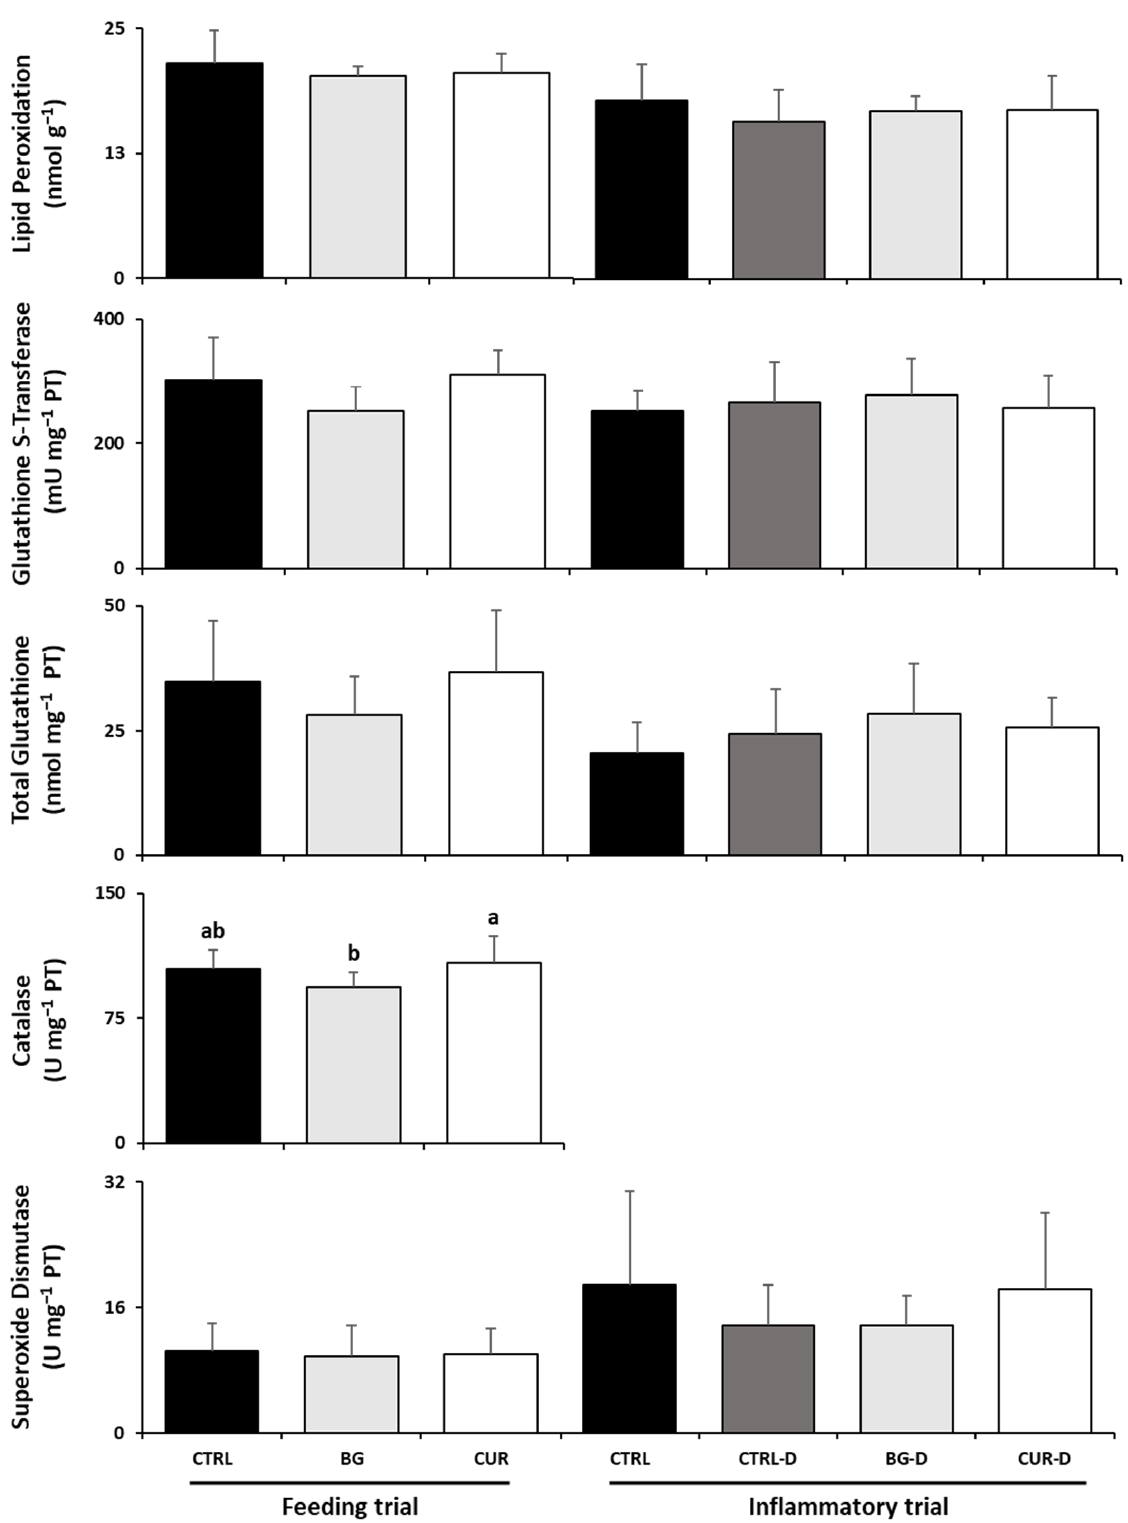
Figure 4. Liver oxidative stress biomarkers of gilthead seabream after the feeding and inflammatory trials ( n = 12). CTRL (control diet), BG ( β -glucans diet), CUR (curcumin diet), CTRL-D (control diet + dextran sodium sulphate − DSS), BG-D ( β -glucans diet + DSS), CUR-D (curcumin diet + DSS). Different letters mean significant differences among dietary treatments ( p < 0.05).